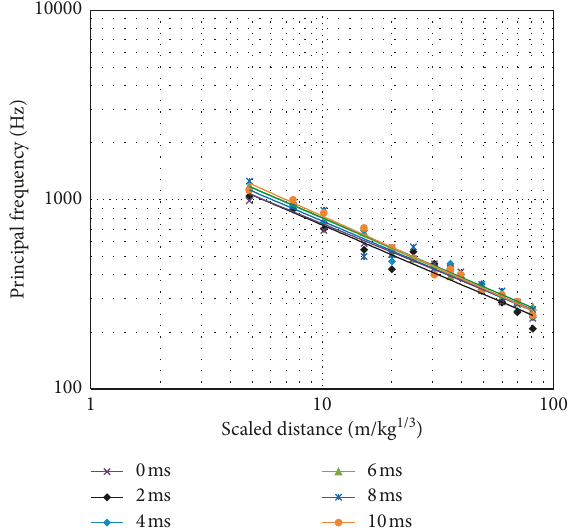
Figure 17: PFs versus scaled distances between delay